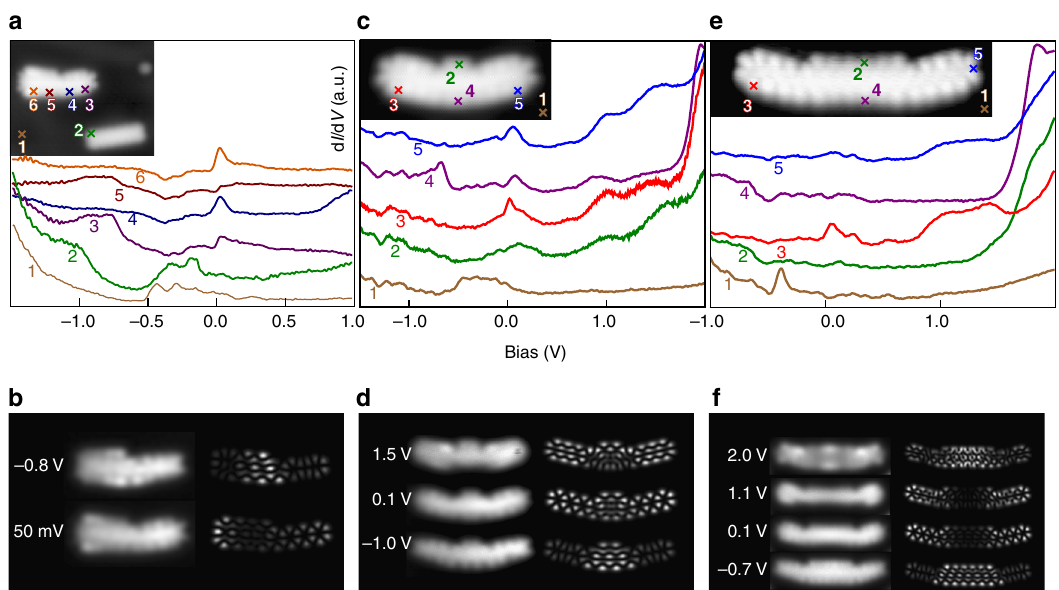
Fig. 3 STS experiments and differential conductance maps of 5/7-GNR heterojunctions. a d I /d V spectra acquired on a 5-GNR and 7-GNR segment of a 5/7- GNR(2,2) heterojunction. For comparison, a spectrum on a three monomer long pure 5-GNR is shown in green . Curves are vertically offset for clarity. Inset : STM topograph of the 5/7-GNR(2,2) heterojunction and neighboring pure 5-GNR ( V = 0.1 V, I = 200 pA). b Experimental ( left ) and simulated ( right ) constant height d I /d V maps recorded at V = − 0.8 V ( top ) and 50mV ( bottom ), respectively. c d I /d V spectra acquired on a 5/7/5-GNR(2,1,2) heterostructure. Curves are vertically offset for clarity. Inset : STM topograph of the 5/7/5-GNR(2,1,2) heterojunction ( V = 0.1 V, I = 500 pA). d Experimental ( left ) and simulated ( right ) constant-height d I /d V maps at V = 1.5V ( top ), V = 0.1 V ( middle ), and V = − 1.0V ( bottom ), respectively. e d I /d V spectra acquired on a 5/7/5-GNR(2,3,2) heterostructure. Curves are vertically offset for clarity. Inset : STM topograph of the 5/7/5-GNR(2,3,2) heterojunction ( V = 0.1 V,